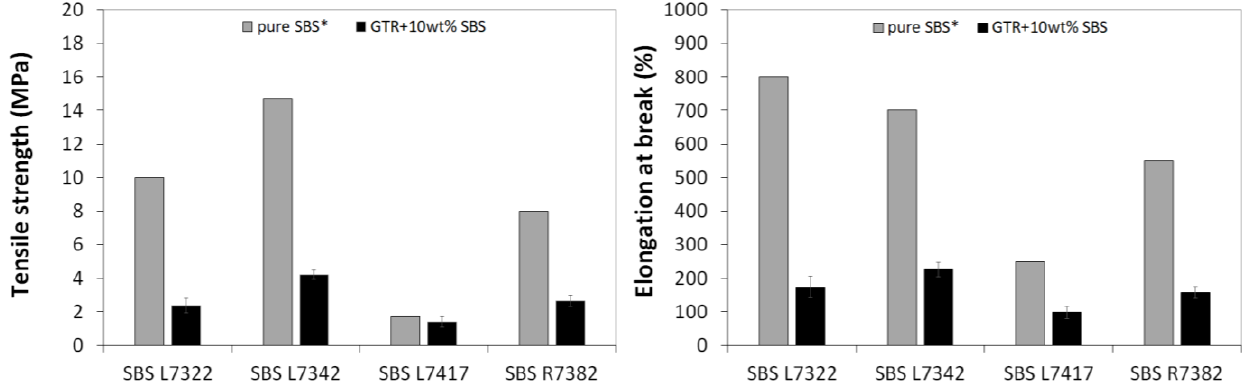
Figure 2. Tensile strength and elongation at break of pure SBS copolymers (* data from technical data sheet provided by producer) and GTR modified by 10 wt% of SBS copolymer as a function of SBS grade.